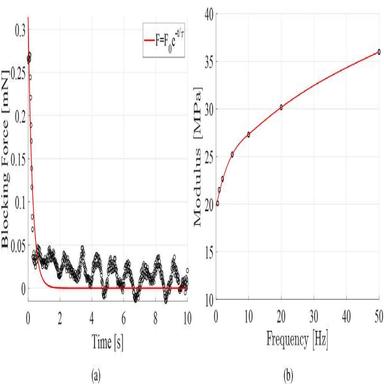
(a) Fitting of the experimental relaxation curve (black scatter) of a blocking force experiment with the Maxwell exponential relaxation curve and (b) dependency of the complex modulus on the frequency.